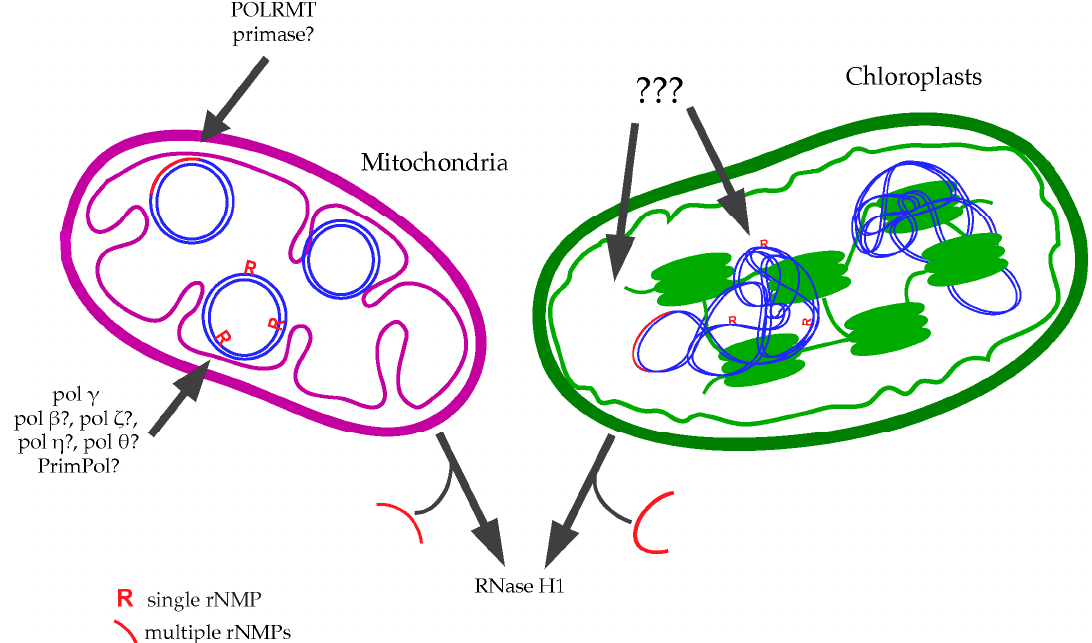
Figure 2. rNMPs incorporation and removal from mitochondrial and chloroplast DNA. Single and multiple ribonucleotides found into the DNA of mitochondria and chloroplasts may result from different sources. Several DNA polymerases might contribute to the incorporation of rNMPs, as demonstrated for pol γ acting on mtDNA. The activity of RNase H1 is essential for processing polyribonucleotide chains synthesized for replication priming, while single rNMPs remain unprocessed due to the absence of RNase H2.